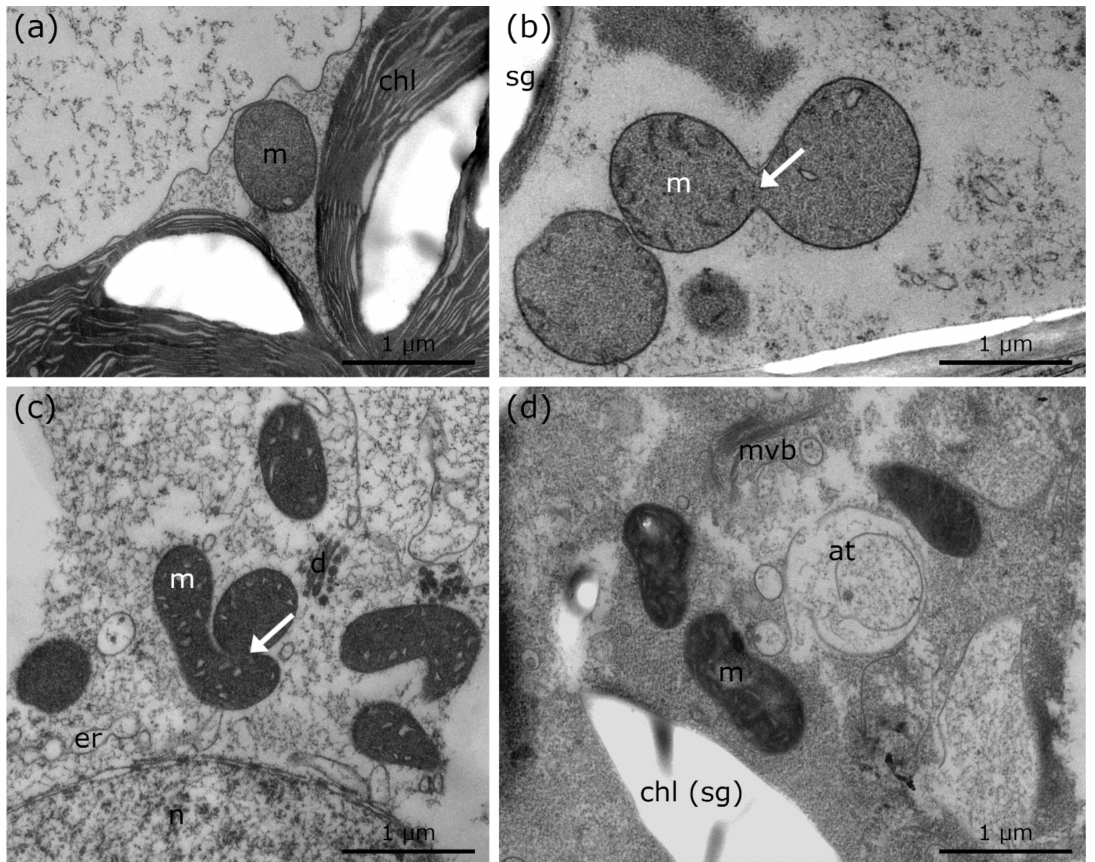
Figure 4. TEM micrographs of Lemna sp. during cold stress in comparison to controls at + 20 ◦ C. ( a ) + 20 ◦ C control of Lemna sp., with single, round mitochondrion. ( b ) + 4 ◦ C, 24 h chilled Lemna sp. depicting mitochondrial fusion (arrow). ( c ) + 4 ◦ C, 3 weeks chilled Lemna sp. with mitochondrial aggregation, fusion (arrow) and bloated ER. ( d ) − 2 ◦ C, extracellularly frozen Lemna sp. with signs of degradation (chloroplast envelope dissolved; autophagic structures), mitochondrial elongation and increased number of multi vesicular bodies. at: autophagic structures, m: mitochondria, mvb: multi vesicular body, er: endoplasmic reticulum, chl: chloroplast, sg: starch grain, d: dictyosome, n: